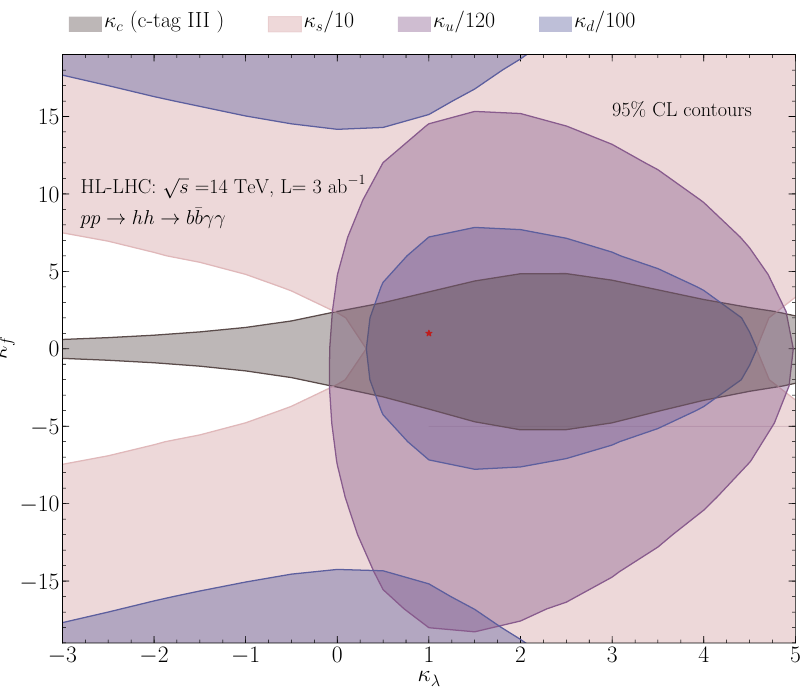
Figure 18 . The expected sensitivity likelihood contours at 95% CL for an integrated luminosity L = 3000 fb (cid:0) 1 for modi(cid:12)ed Higgs trilinear coupling (cid:20) (cid:21) vs the light quark Yukawa couplings scalings (cid:20) q